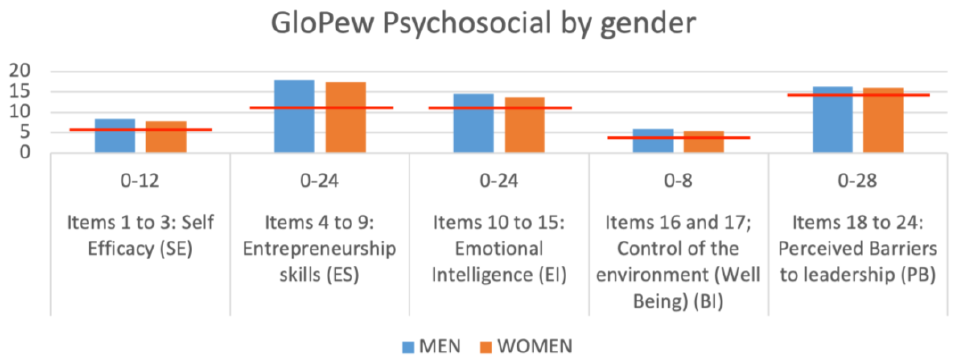
Figure 2. Mean values of the GloPEW psychosocial factors by gender.